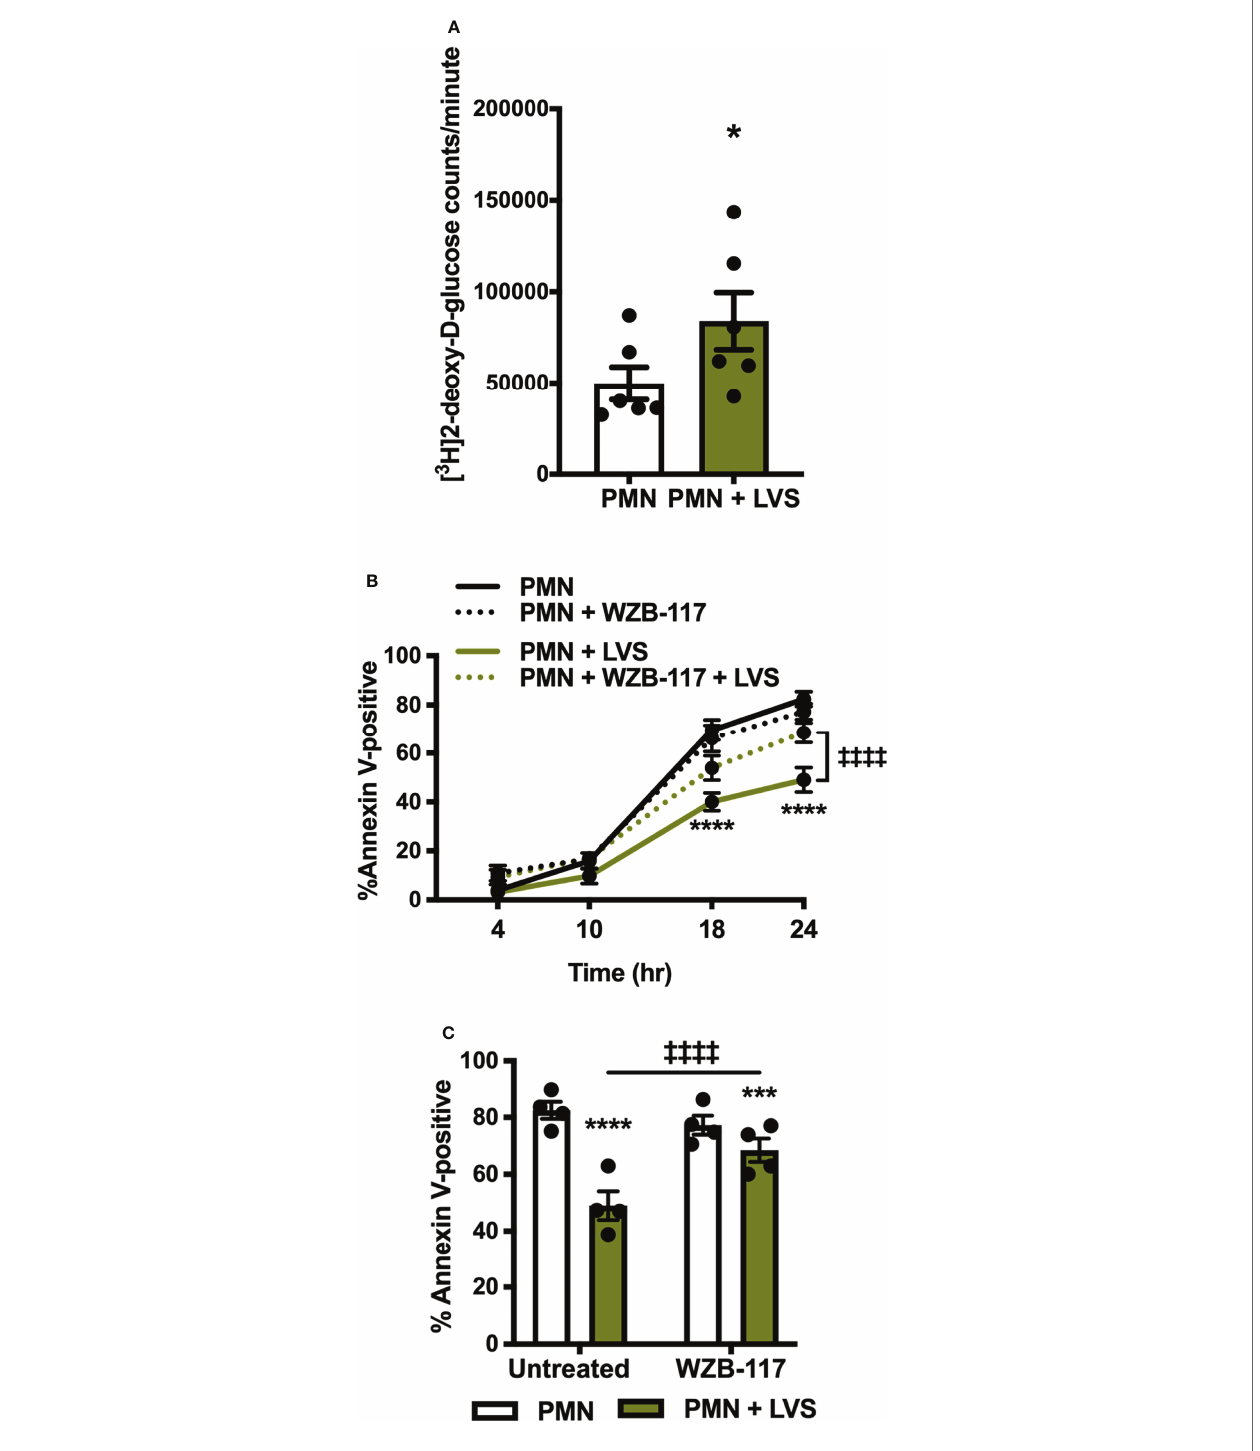
FIGURE 6 | Glucose uptake is increased in LVS-infected PMNs and is required for apoptosis delay. (A) [ 3 H]2-deoxy-D-glucose uptake was measured at 12 hr. * p < 0.05, n=6. (B, C) Apoptosis of control and LVS-infected PMNs in the presence or absence of WZB-117 measured by Annexin V-FITC staining and fl ow cytometry at the indicated timepoints (B) and at 24 h (C) . * p < 0.05, *** p < 0.001, **** p < 0.0001 compared to untreated, control PMNs, ‡‡‡‡ p < 0.0001 compared to untreated, LVS-infected PMNs as indicated,